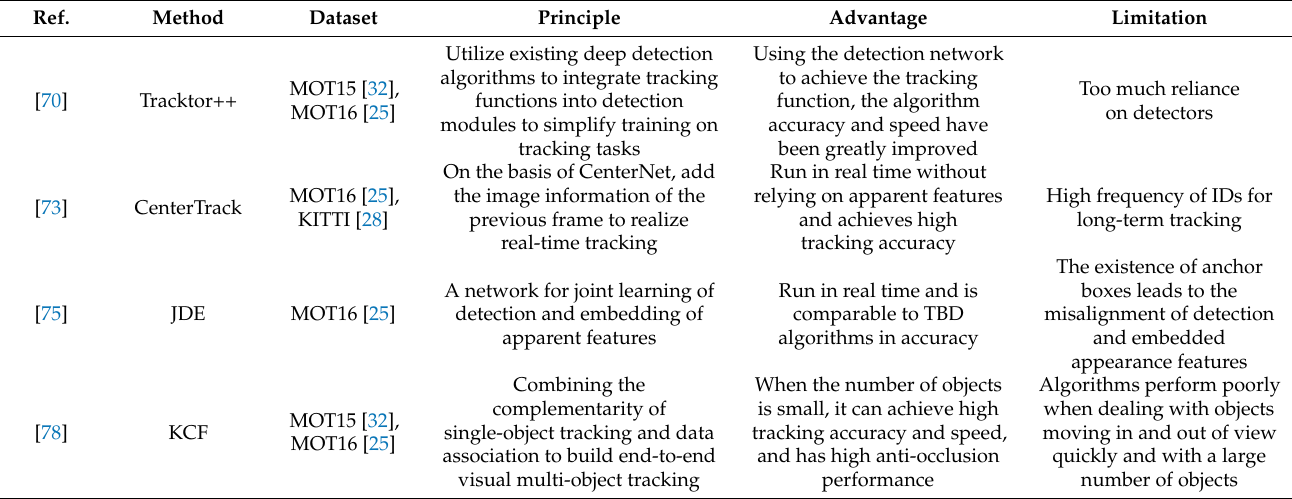
Table 6. Algorithm analysis and comparison based on JDT